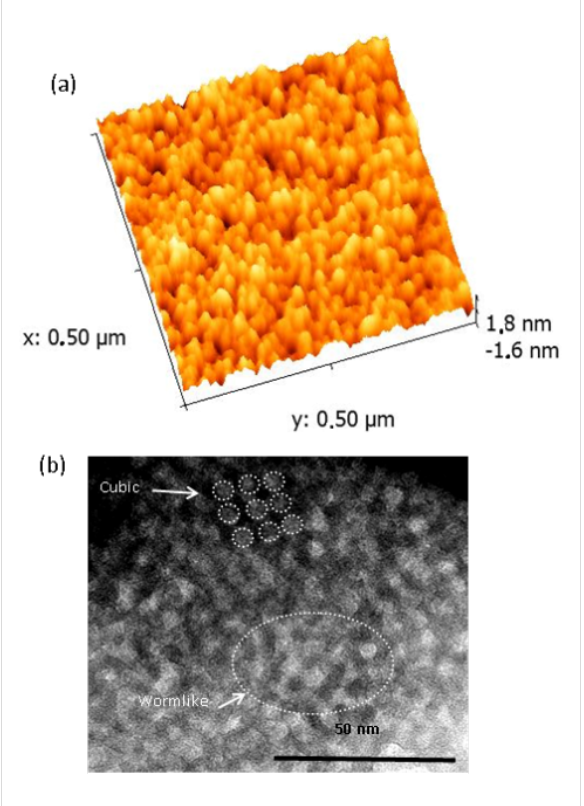
Figure 1: (a) AFM image of the mesoporous TiO 2 film and (b) TEM image showing the ordered–desordered regions of the mesoporous TiO 2